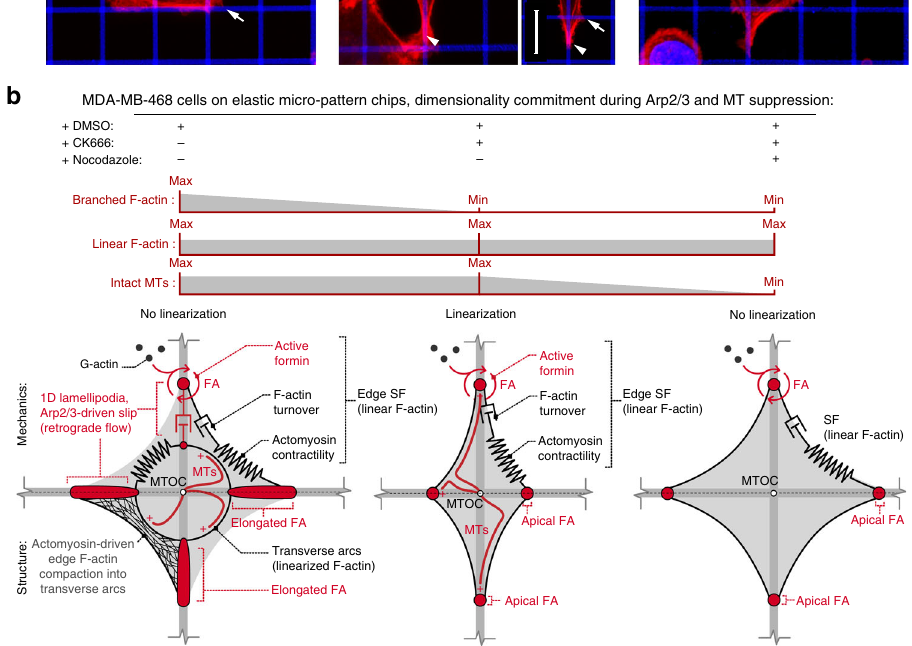
Arp2/3 complex inhibition promotes a uniaxial response to stiff biaxial guidance cues . Arp2/3 inhibition unmasks a steady advancement of protrusions along stiff collagen guidance cues, whereas in non-contractile cells, Arp2/3 is necessary for protru- sion along guidance cues (Fig. 4, Supplementary Figures 5 –